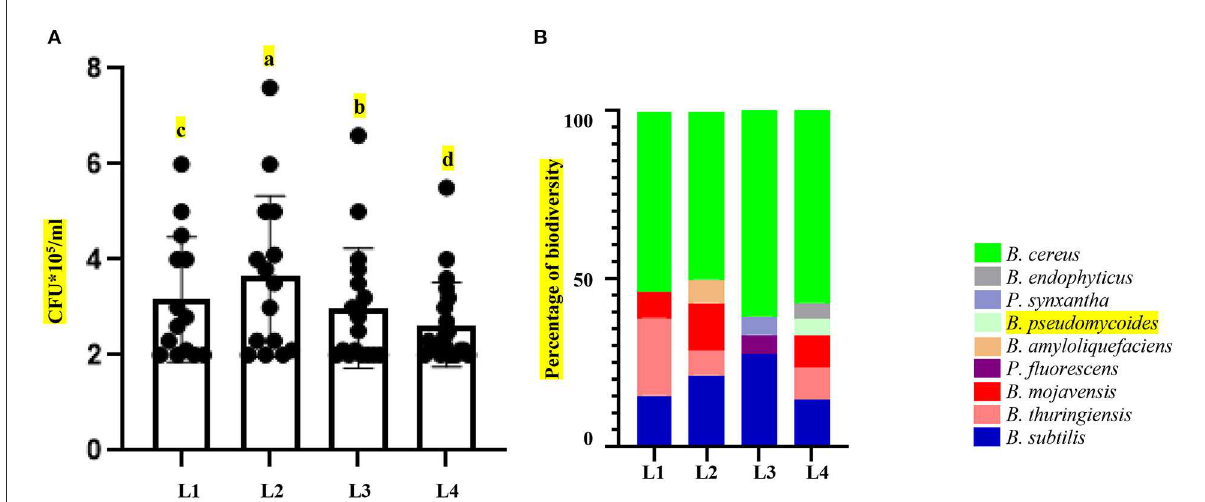
FIGURE2 Changes in microbiome in response to altitude gradient. (A) Colony counting of microbiome (biomass) of the isolates from soil samples collected in various altitudes. (B) Diversity of microbiome isolates collected from various altitudes. Different letters at the top of the graphs indicate statistical differences ( P value < 0.001) in pairwise comparisons by